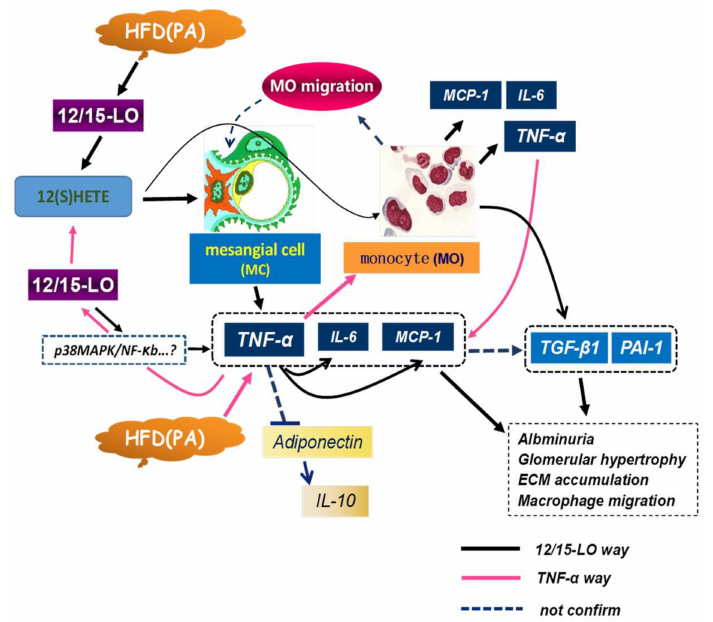
Figure 9. 12/15-LO metabolic way in HFD induced ORG and inflammatory gene expression. 12/15-LO and its lipid product 12(S)-HETE induced mesangial cellular inflammatory gene over- expression and production. 12/15-LO mediated HFD (PA) induced inflammatory factors (TNF- α , IL-6, MCP-1) and anti-inflammatory gene (adiponectin) expression; increased production of TNF- α augments this event by enhancing IL-6 and MCP-1, while 12/15-LO is involved in TNF- α associated IL-6 and MCP-1 regulation, monocyte/macrophage migration, and inflammatory factor secretion. These events play an important role in HFD induced glomerular hypertrophy and inflammatory cytokine